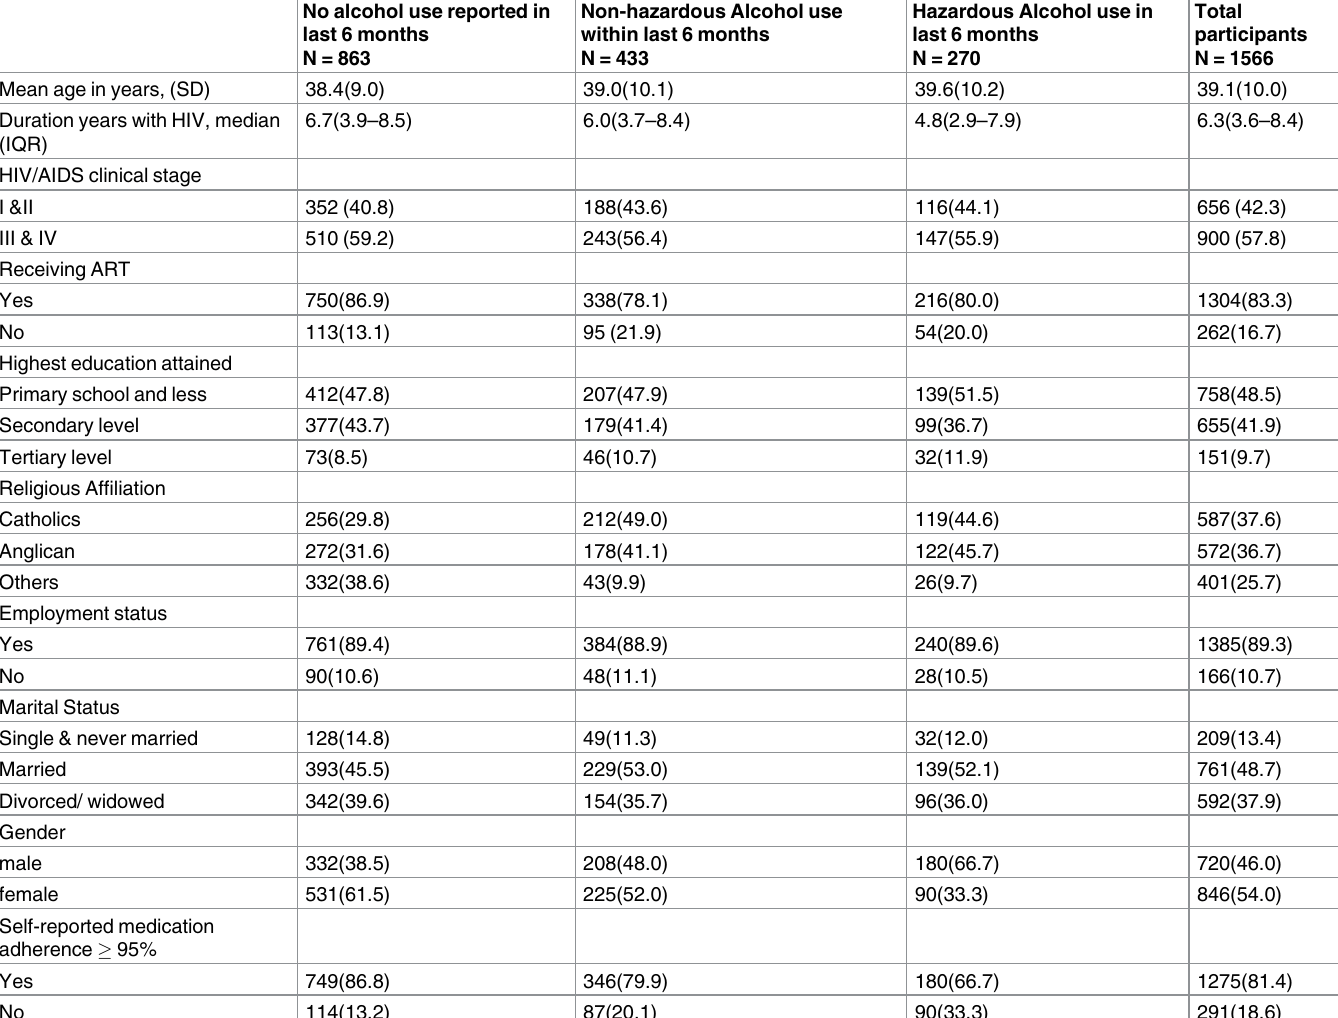
Table 1. Baseline descriptive characteristics of 1566 PLHIV, stratified by alcohol use, category enrolled in the alcohol study at the Infectious Dis- eases Institute, Kampala Uganda. No alcohol use reported in last 6